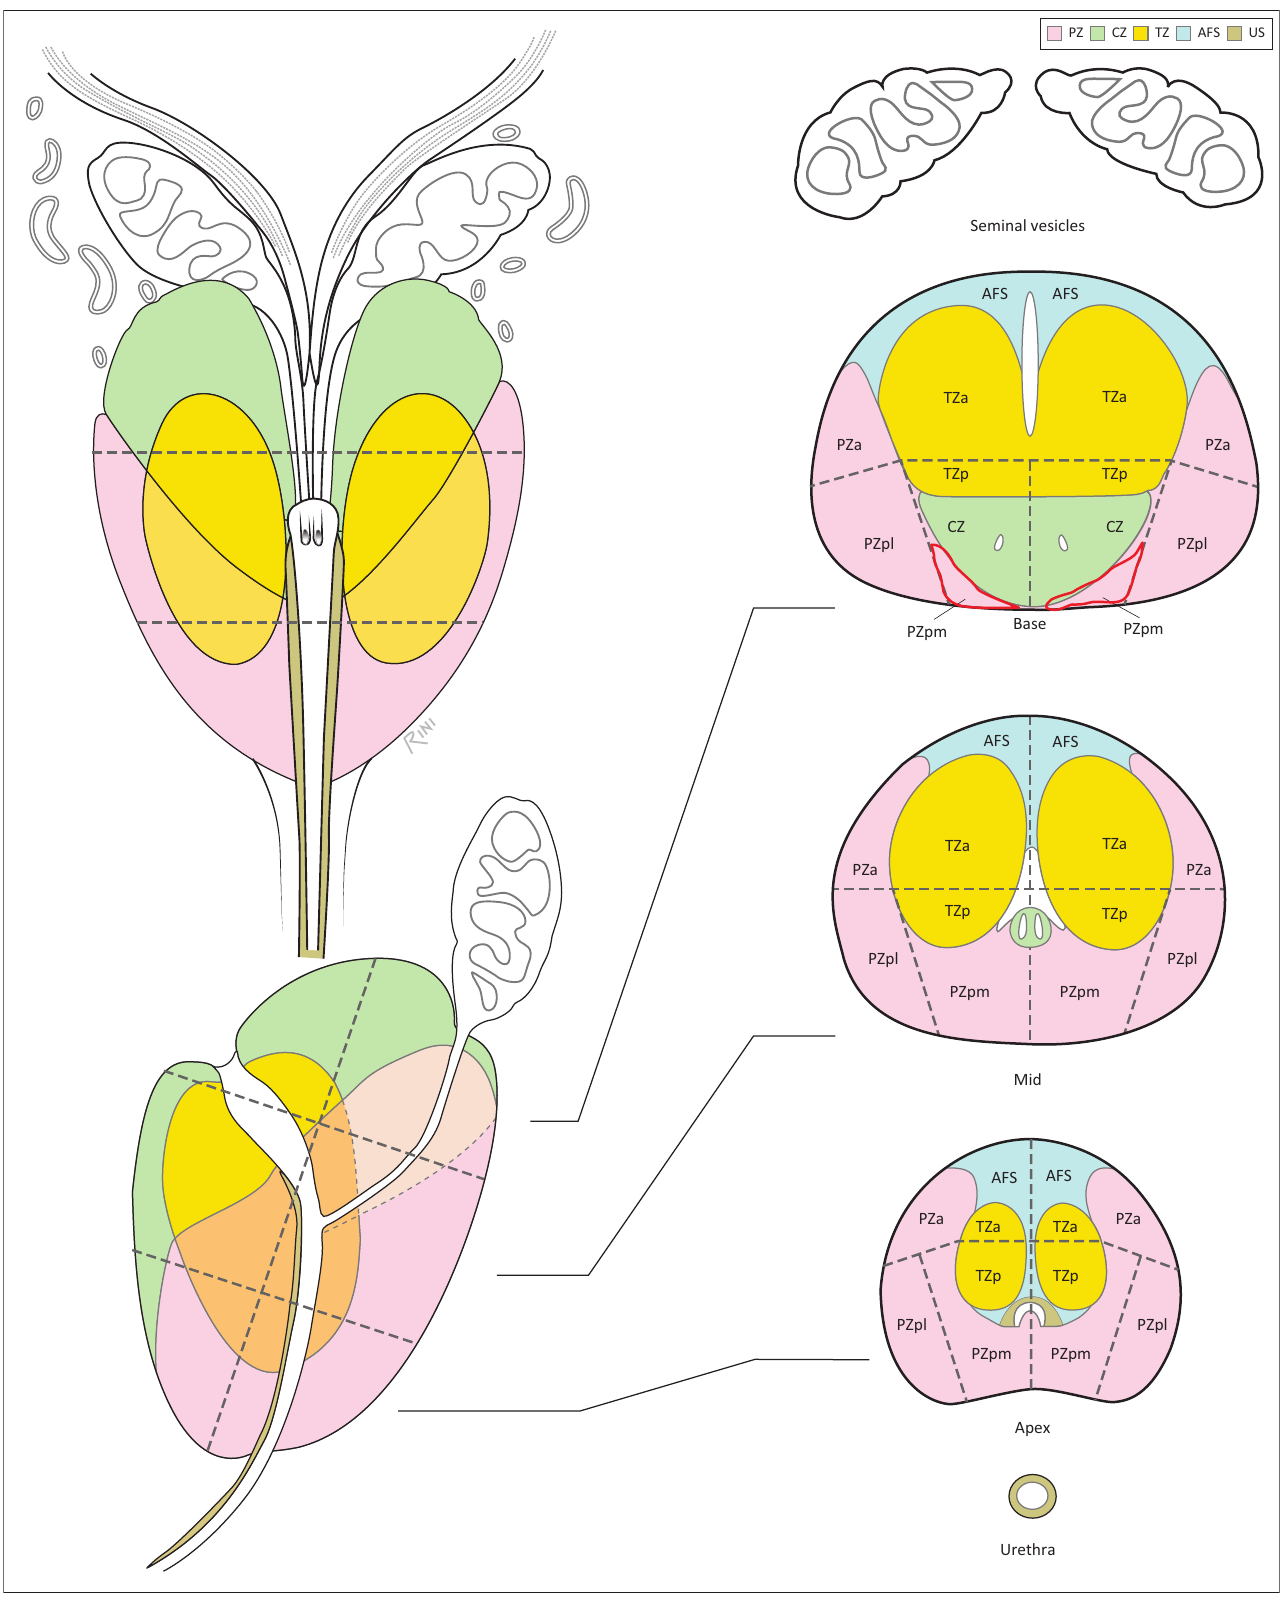
FIGURE 1: Sector zone map demonstrating the named 41 zones of the